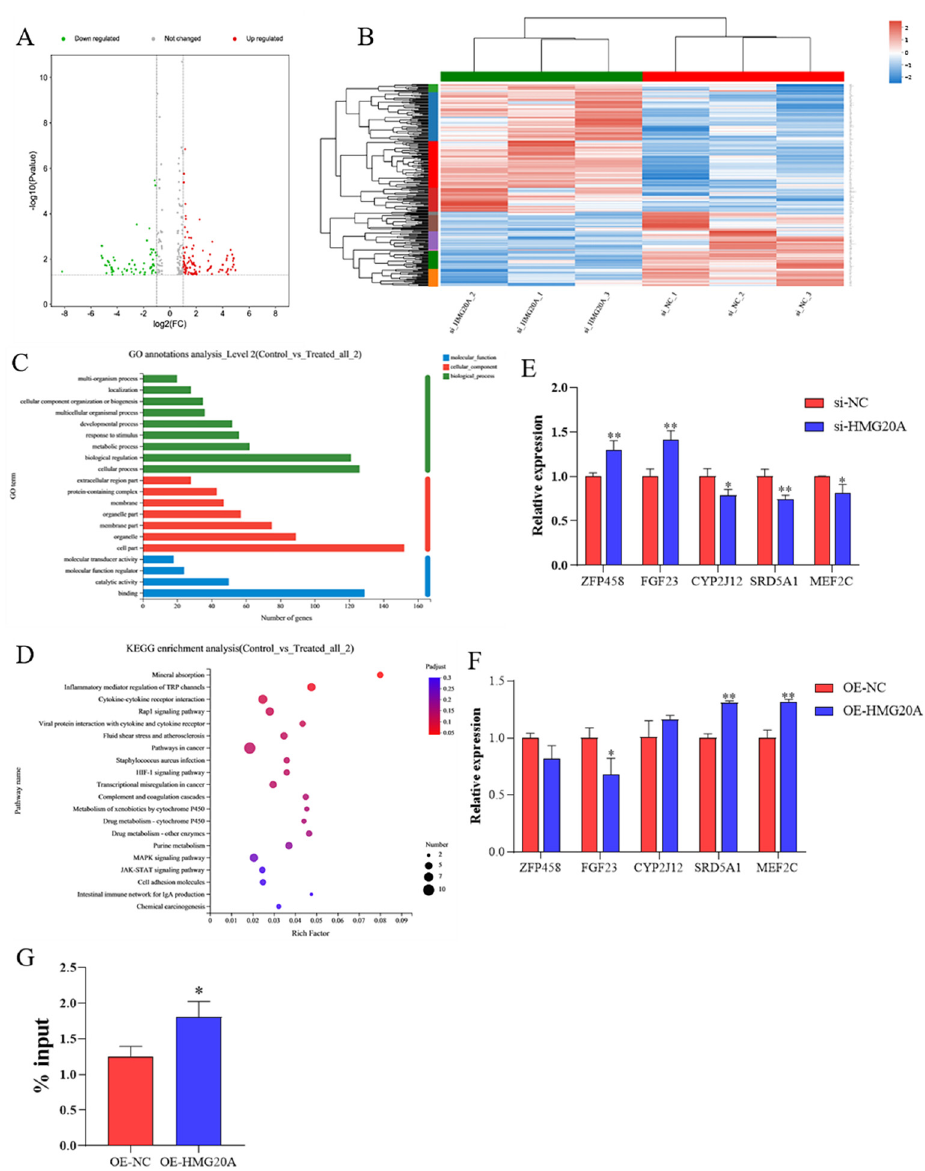
Figure 3. Transcriptomics data. After 7 days of adipogenic differentiation, C3H10T1/2 cells with or without HMG20A knockdown were collected for transcriptome analysis. ( A ) Volcano plot of the differentially expressed genes (DEGs). ( B ) The heatmap of the DEGs. ( C ) GO analysis of DEGs. ( D ) KEGG analysis of DEGs. ( E , F ) mRNA levels of 5 candidate target genes in C3H10T1/2 cells that interfere with or overexpress HMG20A. ( G ) ChIP-qPCR analyses of MEF2C reporter levels in C3H10T1/2 cells. Results are presented as ChIP/input DNA ratios (in percent) at the respective promoter regions. n = 3. Presented as means ± SD (* p < 0.05, ** p <